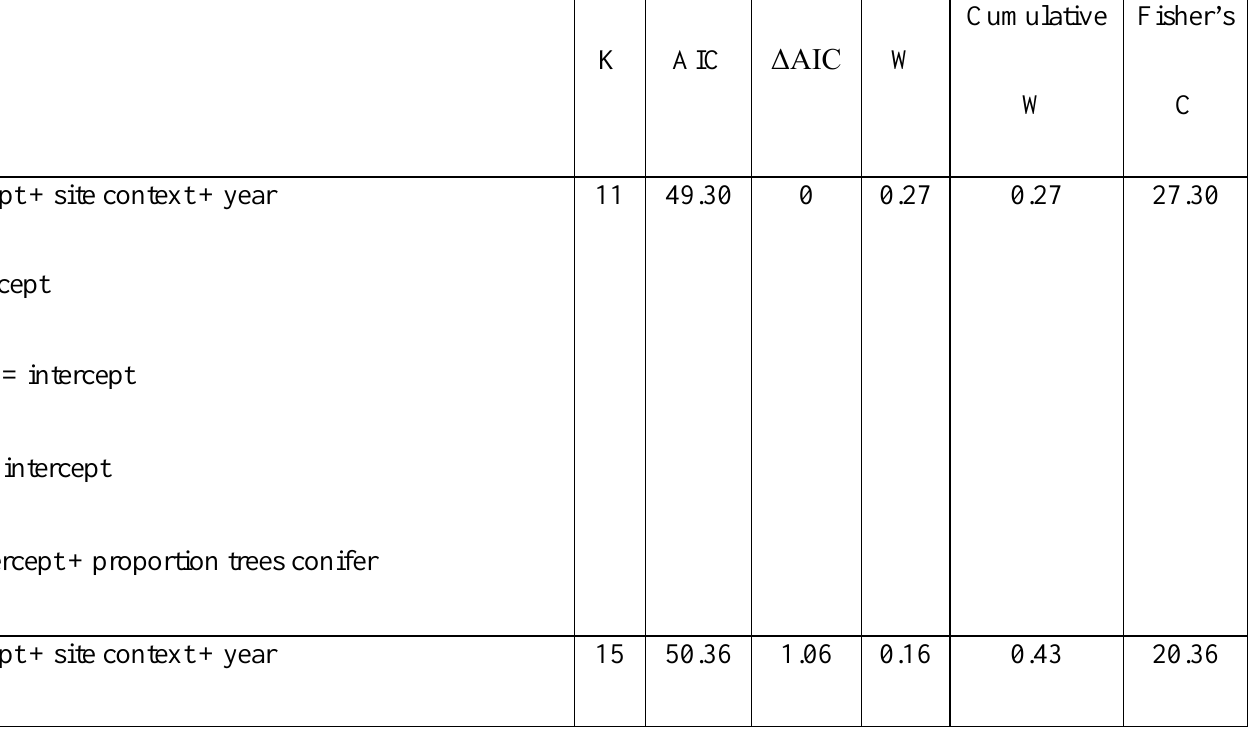
Table A1.2. AIC model selection results for path models examining relationships between factors hypothesized to effect territory size and breeding success. K represents the number of parameters in each path model. W and Cumulative W represent Akaike weights and cumulative model weights, respectively. Fisher’s C statistic = -2*ln(model likelihood). Path model equations represent individual regression equations or sub-models comprising each path model, where each predictor variable represents a path in the path model. ⱡ indicates random effect included in sub-model for study